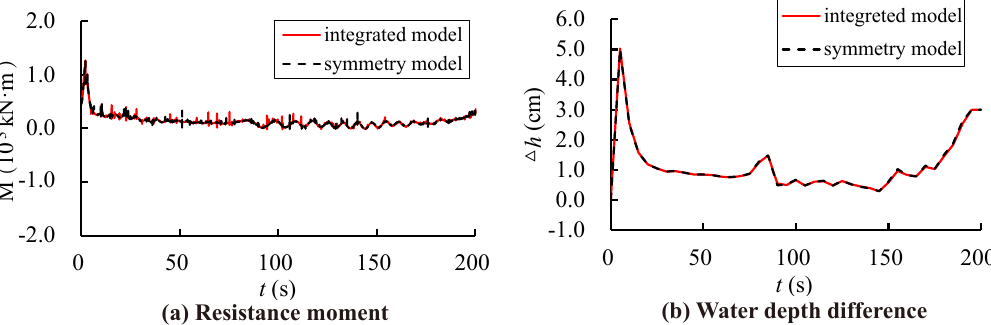
Figure 11. The hydrodynamic characteristics between the integrated model and the symmetry